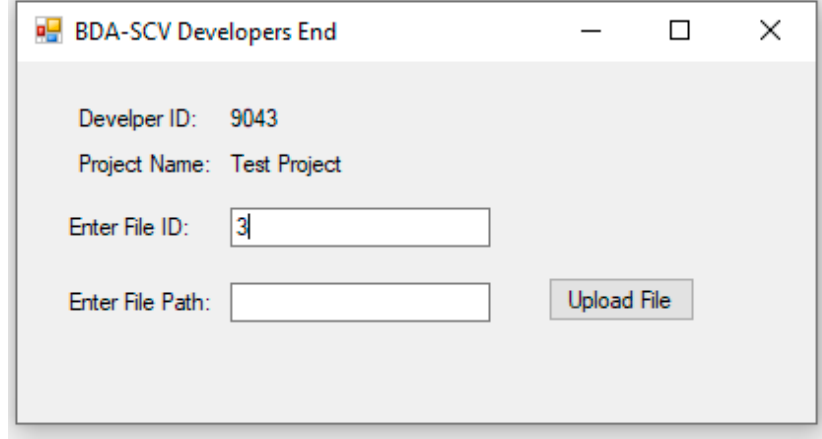
Figure 15. BDA-SCV file upload GUI.